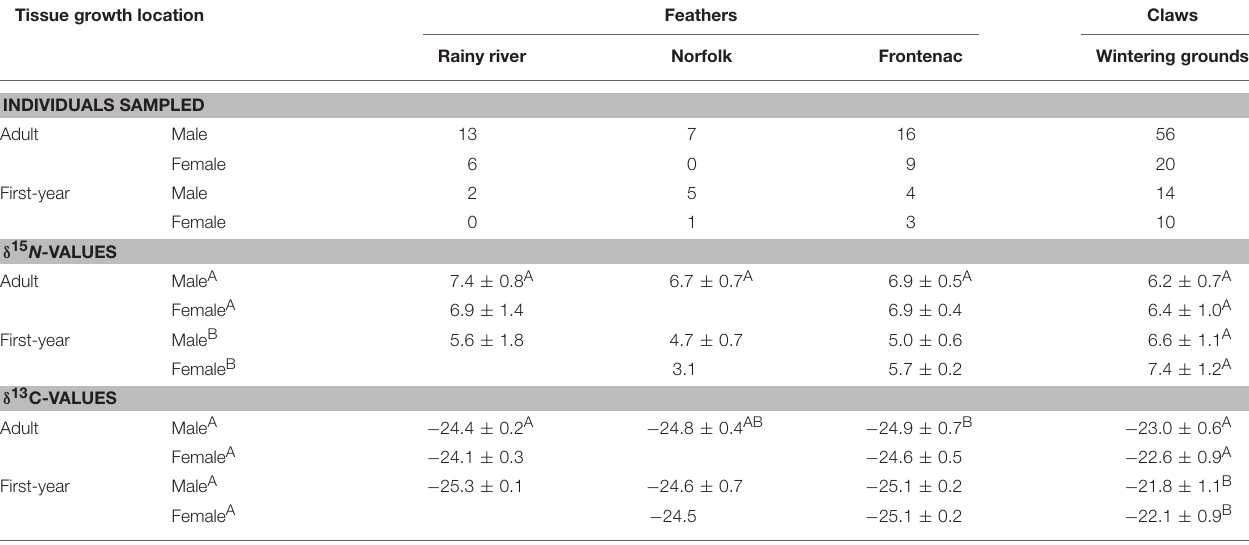
TABLE 1 | Contemporary tissue sample sizes and mean ± standard deviations of isotope values from A. vociferus breeding at three localities in Ontario (see Figure 1 ). Tissue growth location Feathers Claws Rainy river Norfolk Frontenac Wintering grounds